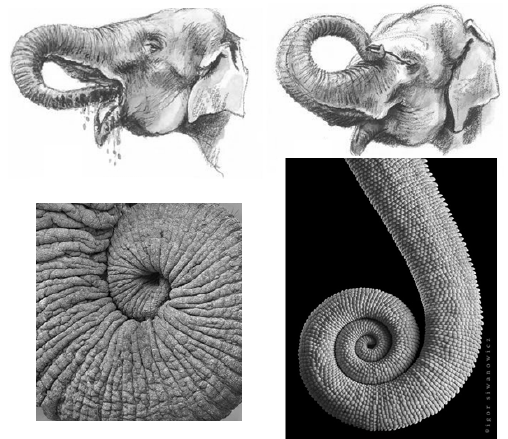
Fig. 11. Forward and reverse twisting of the elephant trunk, drawings from the top left and right and bottom left. Twisting the tail of the reptile-figure bottom right.